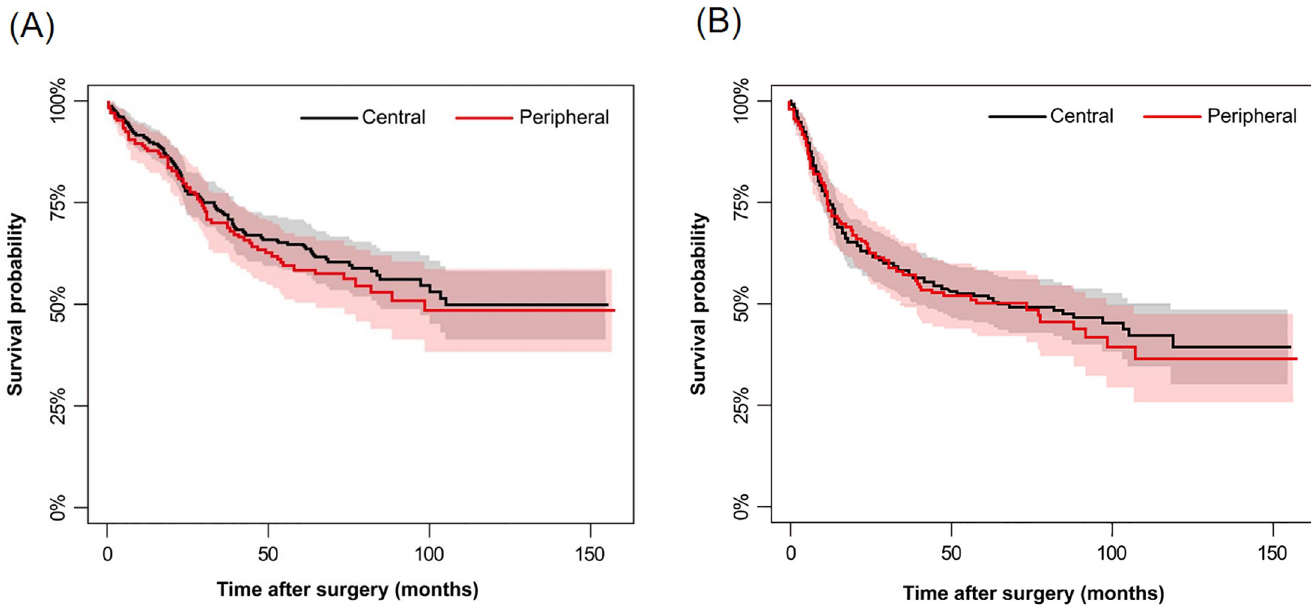
Fig 4. Comparison of calculated OS and DFS using the Kaplan-Meier method according to tumor location. Overall survival (A) and disease-free survival (B) curves are shown according to tumor location. Survival rates were calculated by Kaplan-Meier method. Standard errors were calculated using Greenwood’s formula. No significant difference was observed between the two groups. Gray and pink areas represent the 95% confidence intervals of the black and red plots, respectively.